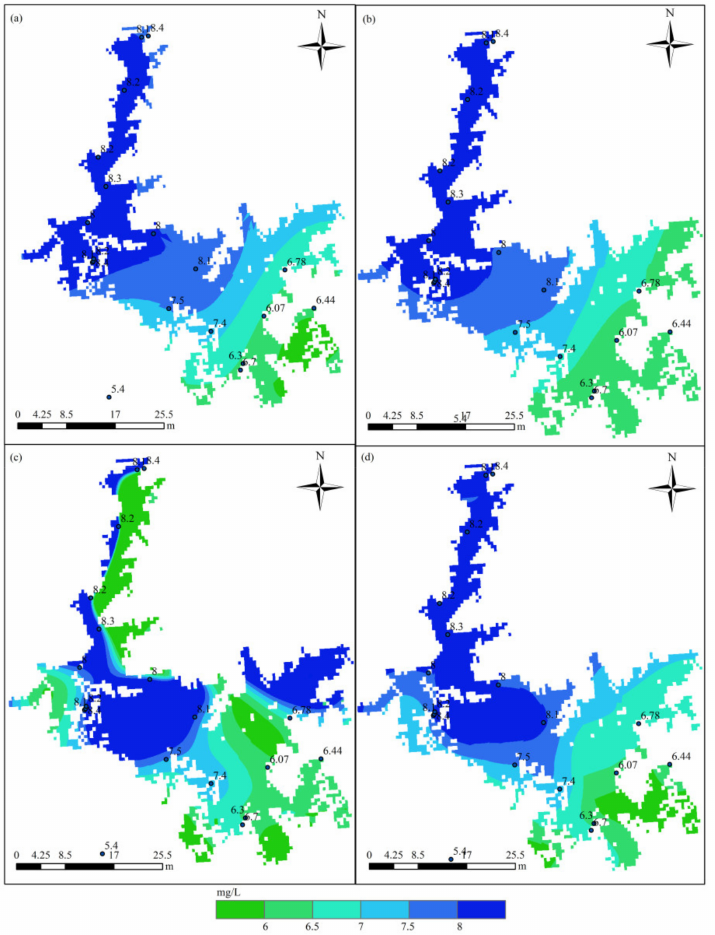
Figure 3. Spatial distribution of DO in Poyang Lake in July using different methods: ( a ) cokriging; ( b ) the SVM; ( c ) HASM; ( d ) HASM_MOD.